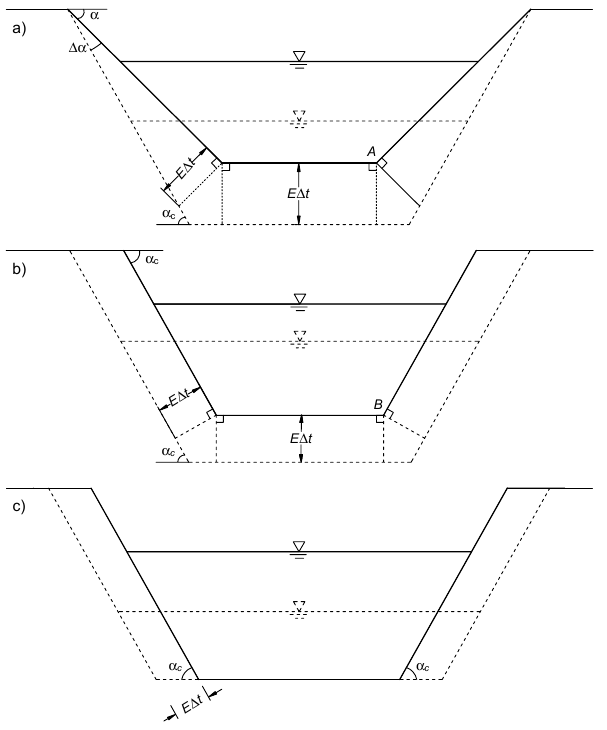
Fig. 1. Breach enlargement process. (a) Stage I, (b) stage II, and Fig. 1. Breach enlargement process. ( a ) stage I; ( b ) stage II; ( c ) stage III. (c) stage III. Fig. 1. Breach enlargement process. ( a ) stage I; ( b ) stage II; ( c ) stage III. Fig. 1. Breach enlargement process. ( a ) stage I; ( b ) stage II; ( c ) stage III.